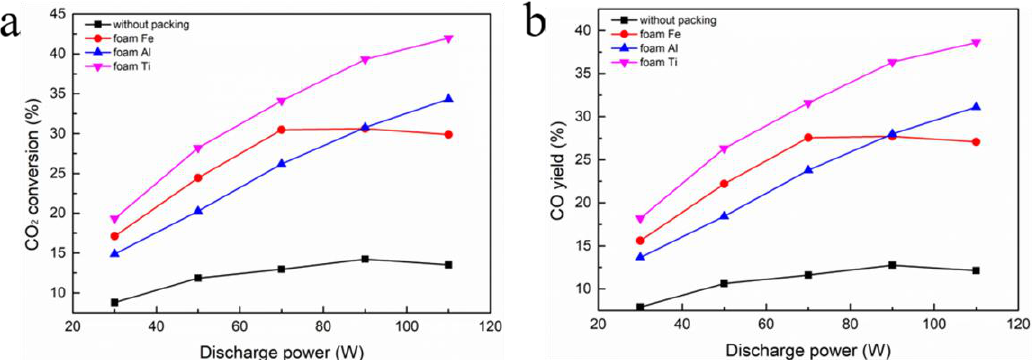
Figure 5. Effect of packing materials on: ( a ) CO 2 conversion; ( b ) CO yield.